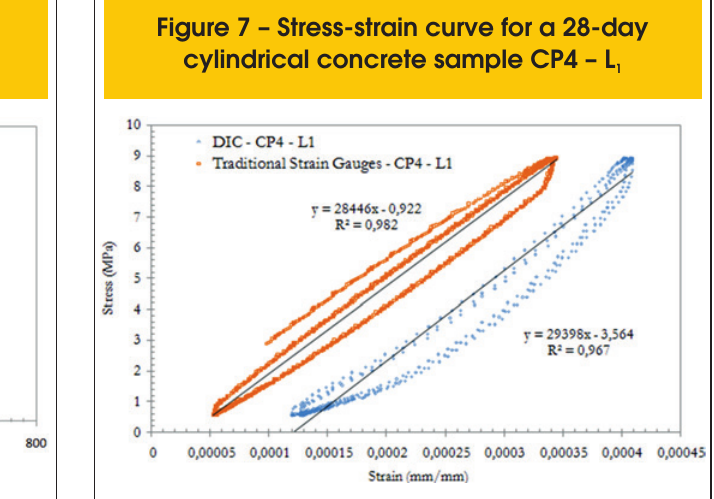
Figure 6 – Curve deformation versus time for specimen CP4 – L